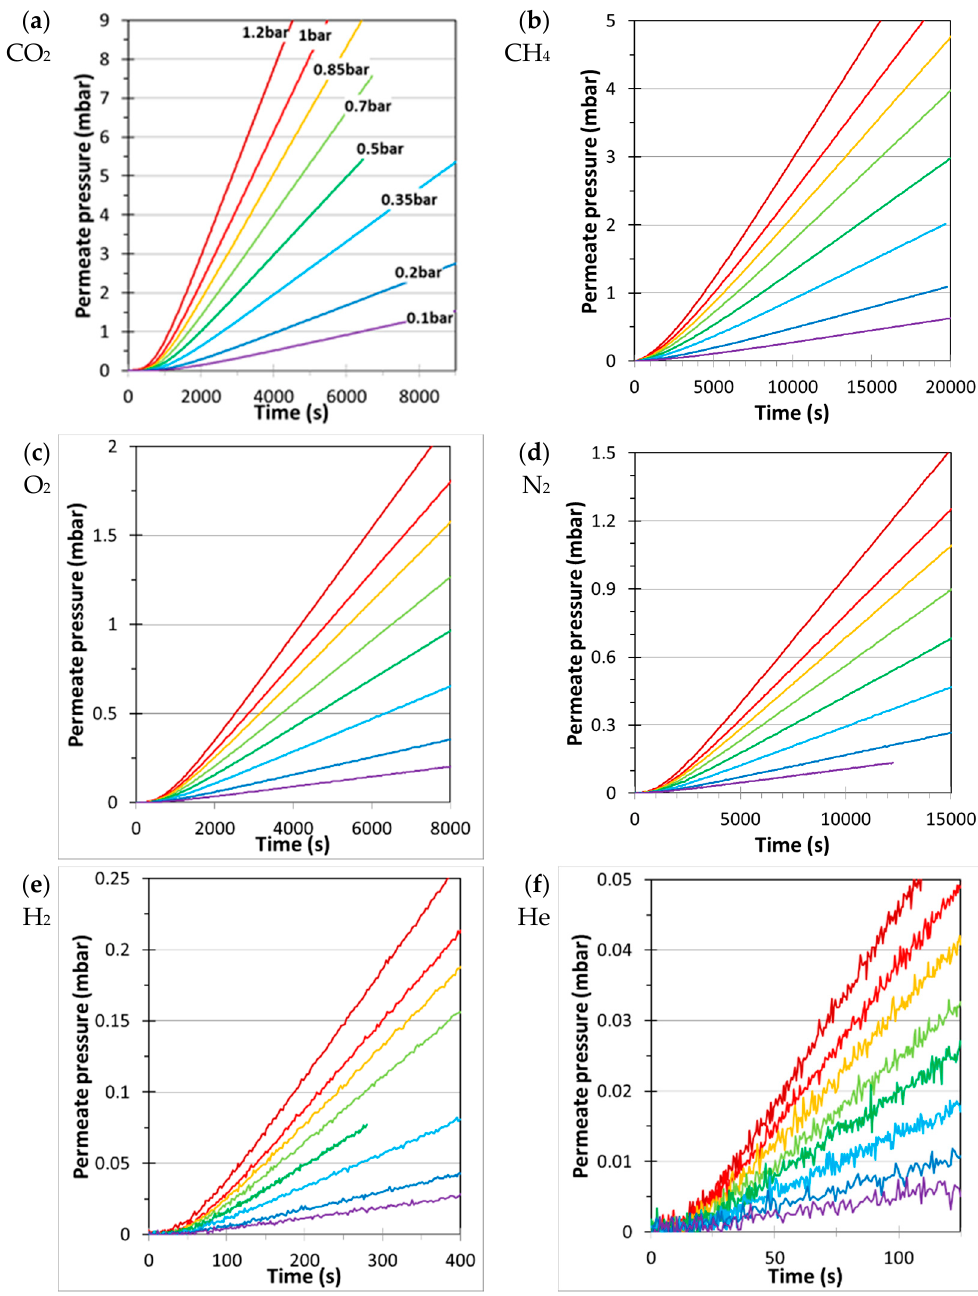
Figure 3. Example of typical permeation curves for ( a ) CO 2 , ( b ) CH 4 , ( c ) O 2 , ( d ) N 2 , ( e ) H 2 , and ( f ) He in Pebax ® 1657 / Cu II 2 (S,S)-hismox in the pressure range 0.1 to 1 bar at 25 ◦ C in the constant volume / pressure increase instrument.